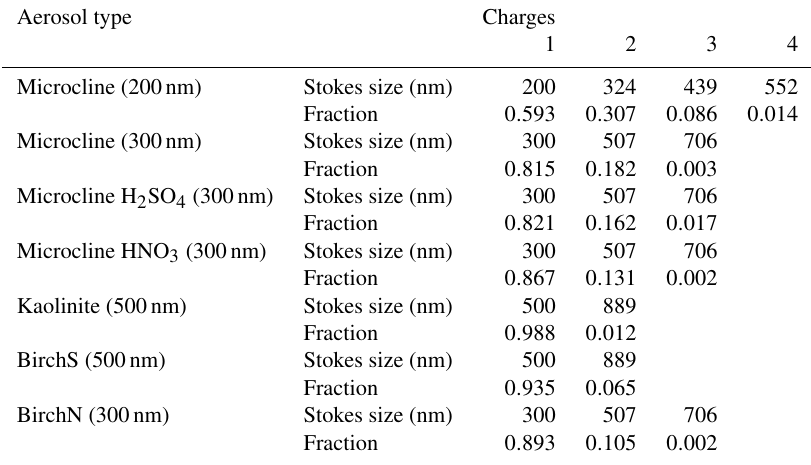
Table 1. Size and fraction of single- (1) or multiple-charged particles (2, 3, and 4) of the resulting aerosol after size selection and the cyclone. Aerosol